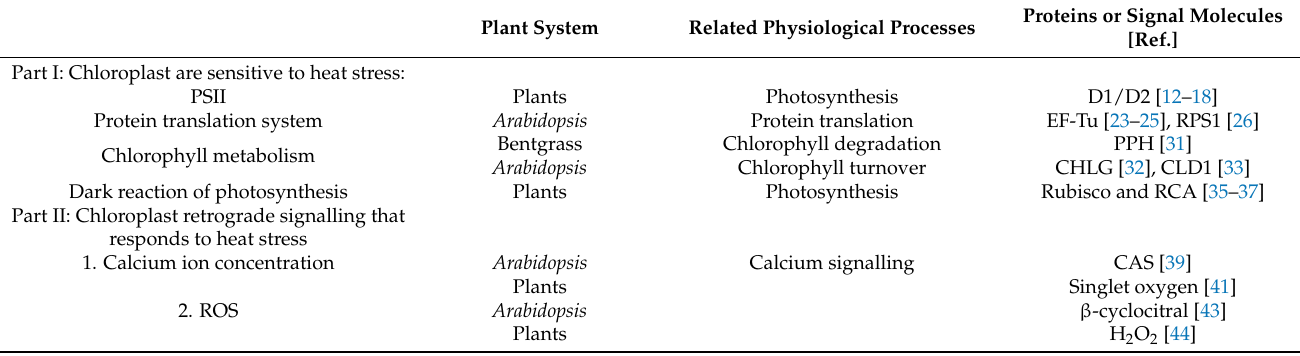
Table 1. Summary of the responses of chloroplast and chloroplast retrograde signalling to heat, and chloroplast-related plant heat